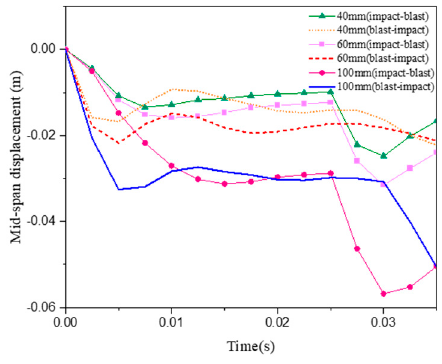
Figure 13. Damage states of beams under combined loads of different longitudinal reinforcement spacing.